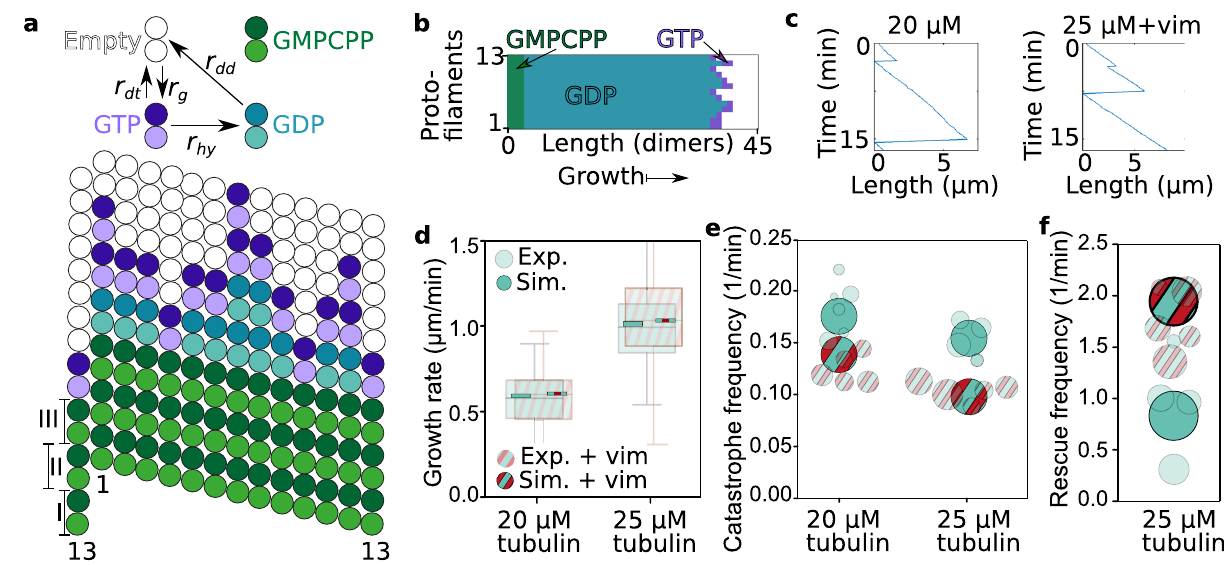
Fig. 5 A Monte-Carlo simulation shows that transiently binding IFs stabilize dynamic microtubules. a Illustration of the reaction rates (top) and simulated microtubule lattice with 13 proto fi laments and a seam with a longitudinal displacement of 1.5 dimers (bottom). b Typical simulated microtubule growing from a GMPCPP (guanylyl-( α , β )-methylene-diphosphonate) seed with dimers either in the GTP (purple) or in the GDP state (cyan). c Typical length-time plot (kymograph) of a simulated microtubule in 20 μ M free tubulin solution without vimentin tetramers (left) or in 25 μ M free tubulin solution with 2.3 μ M vimentin tetramers (right). d – f We reproduced the experimental data shown in Fig. 1d – g (shown here in a semi-transparent fashion, for